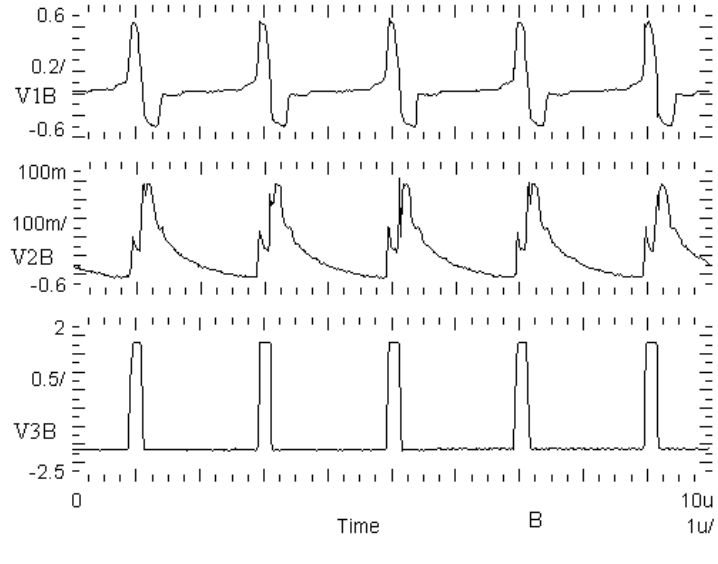
Figure 10. Oscillograms of V1B, V2B, V3B waveforms of CMOS oscillator